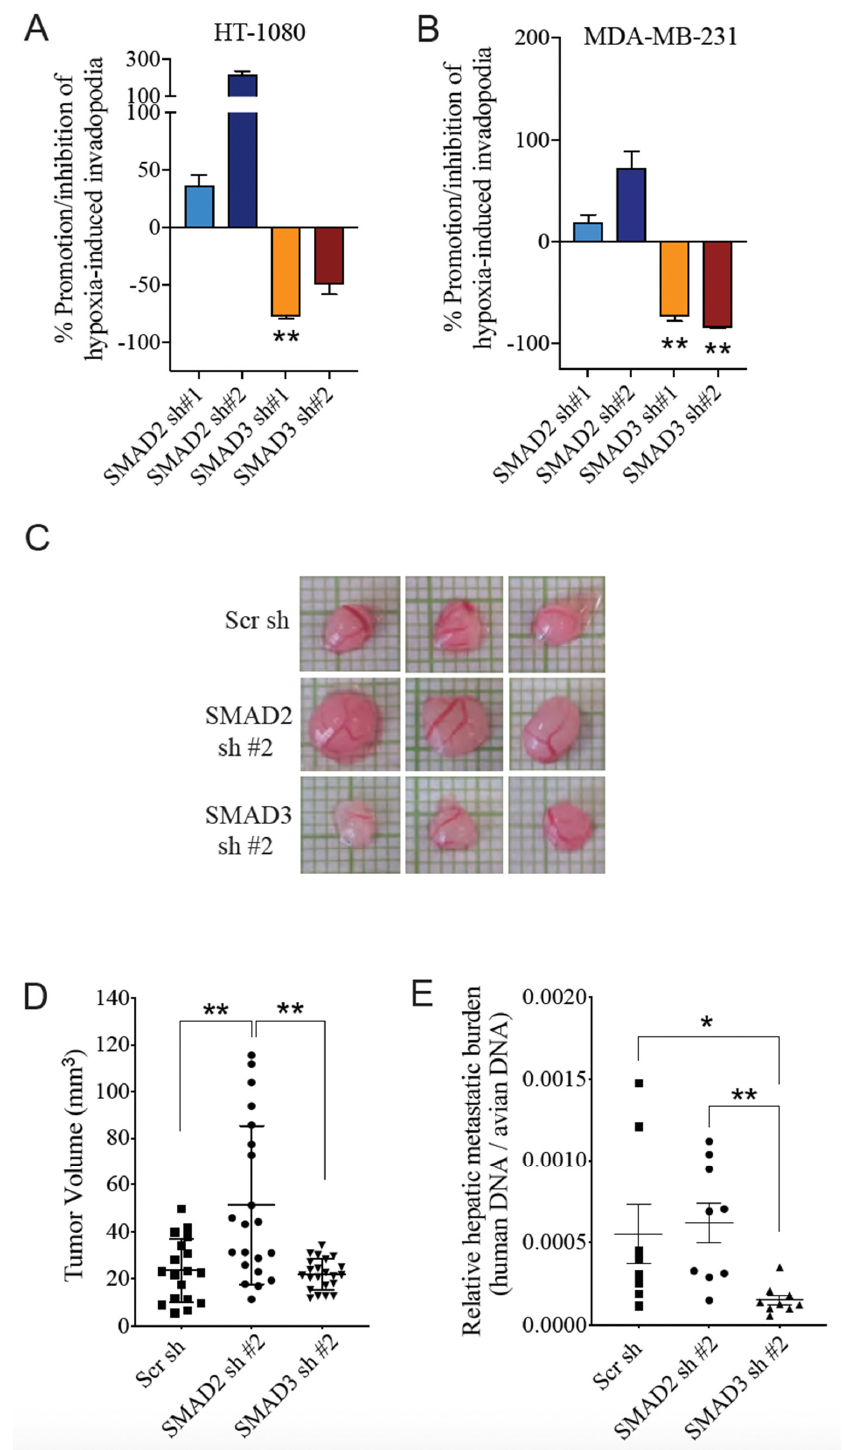
Figure 4. Effect of SMAD2 and SMAD3 Depletion on Hypoxia-Induced Cancer Cell Invasion. ( A , B ) Percentage of promotion/inhibition of hypoxia-induced invadopodia formation by HT-1080 ( A ) and MDA-MB-231 ( B ) cells, compared to Scr sh. ( C – E ) HT-1080 cells transduced with scrambled, SMAD2- or SMAD3- targeted shRNA were grown on chicken chorioallantoïc membrane (CAM) for 7 days. ( C ) Representative images of xenograft tumors obtained. Xenograft tumor size ( D ) and relative amount of spontaneous liver metastasis in the chicken embryo ( E ) were quantitated ( n = 20–24 per group). Data are presented as mean ± SEM. * p < 0.05; ** p <